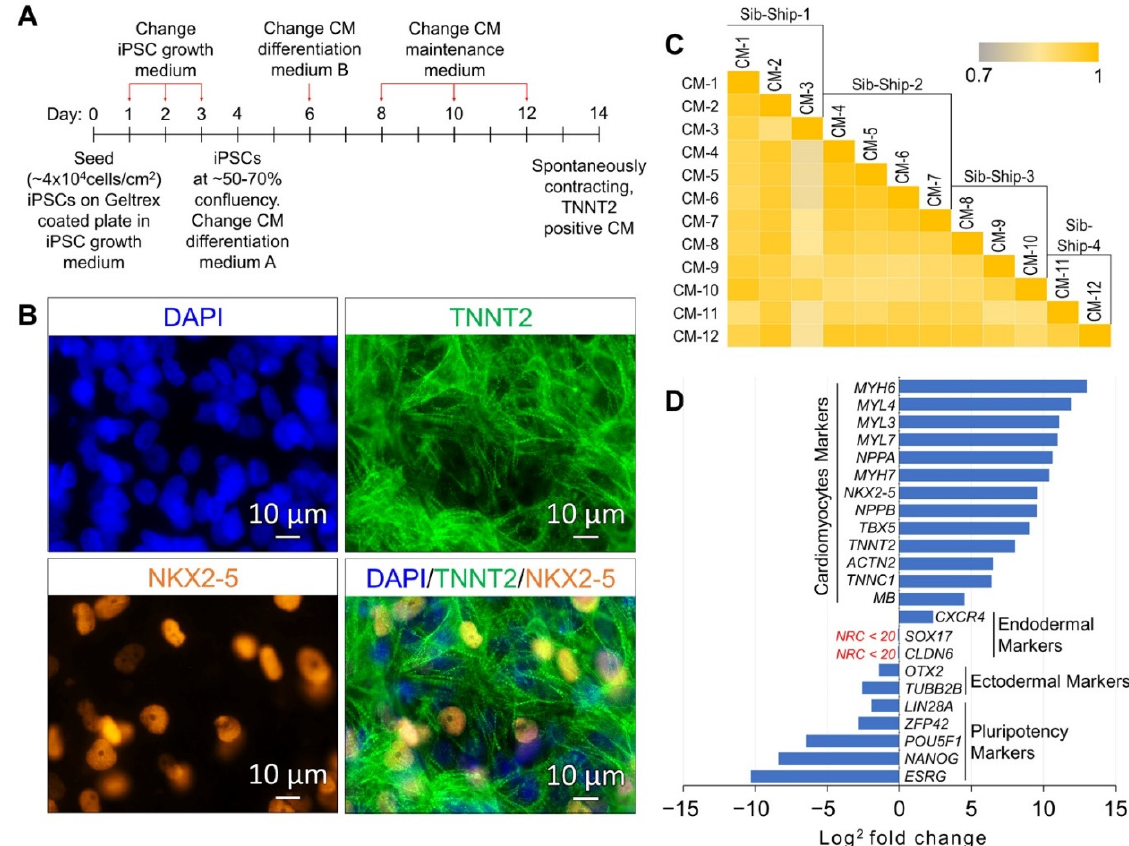
Figure 1. Characterization of induced pluripotent stem cell (iPSC)-generated cardiomyocytes (CMs) by ICC and gene expression analysis. ( A ) Schematic diagram outlining the protocol of iPSC to CM differentiation. ( B ) A representative ICC image panel of iPSC-generated CMs showing expression of the CM markers NKX2-5 and TNNT2. ( C ) Correlation coefficient (r 2 ) plot based on the 12,280 genes found expressed (NRC ≥ 20) in 12 iPSC-generated CMs. ( D ) Gene expression plot showing average differential expression of cardiomyocytes, pluripotency, ectodermal, and endodermal markers between 12 iPSCs and their generated 12 CM